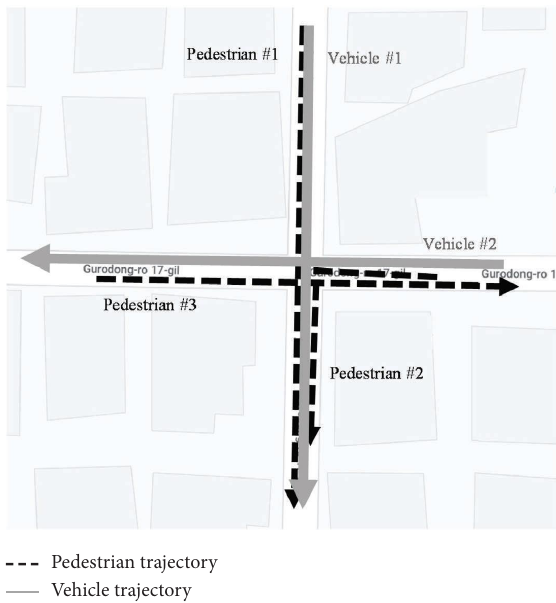
Figure 5: Test scenario description. Trajectories of three pedestrians and two vehicles were